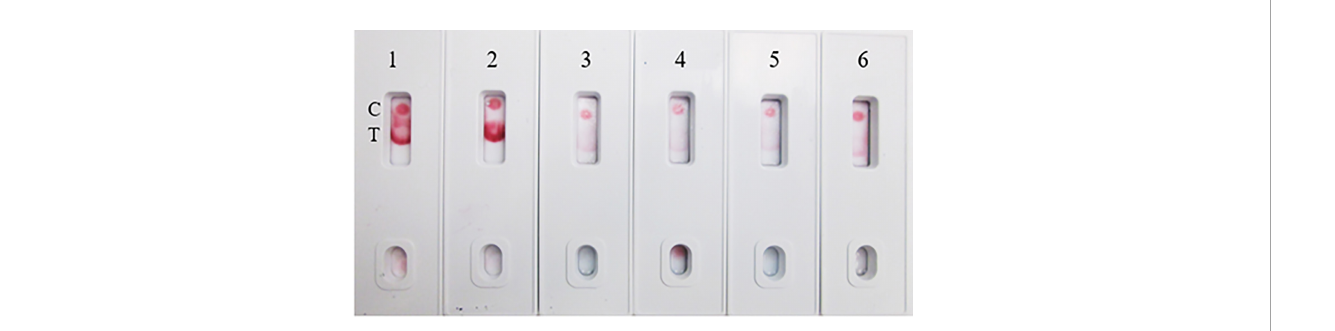
FIGURE 9 LFIA Speci fi city/Cross-reactivity with In fl uenza Virus Panel. 1. NR-52397 SARS-CoV-2 spike protein (positive control), 2. NR-52366 SARS-CoV-2 RBD protein (positive control), 3. NR-42006 In fl uenza B Virus, B/Brisbane/33/2008 (Victoria Lineage), 4. NR-42007 In fl uenza A Virus, A/Wisconsin/15/2009